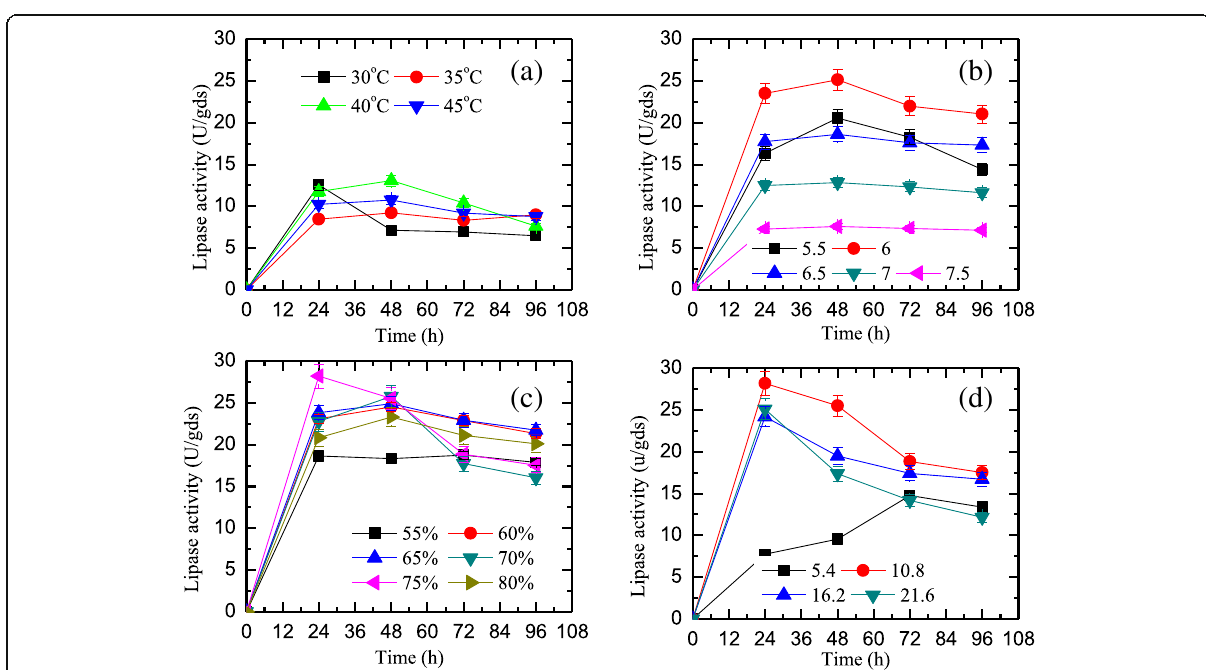
Fig. 3 Evaluation of optimum conditions for maximum lipase activity using Aspergillus niger MTCC 872. a Temperature. b pH. c Moisture content